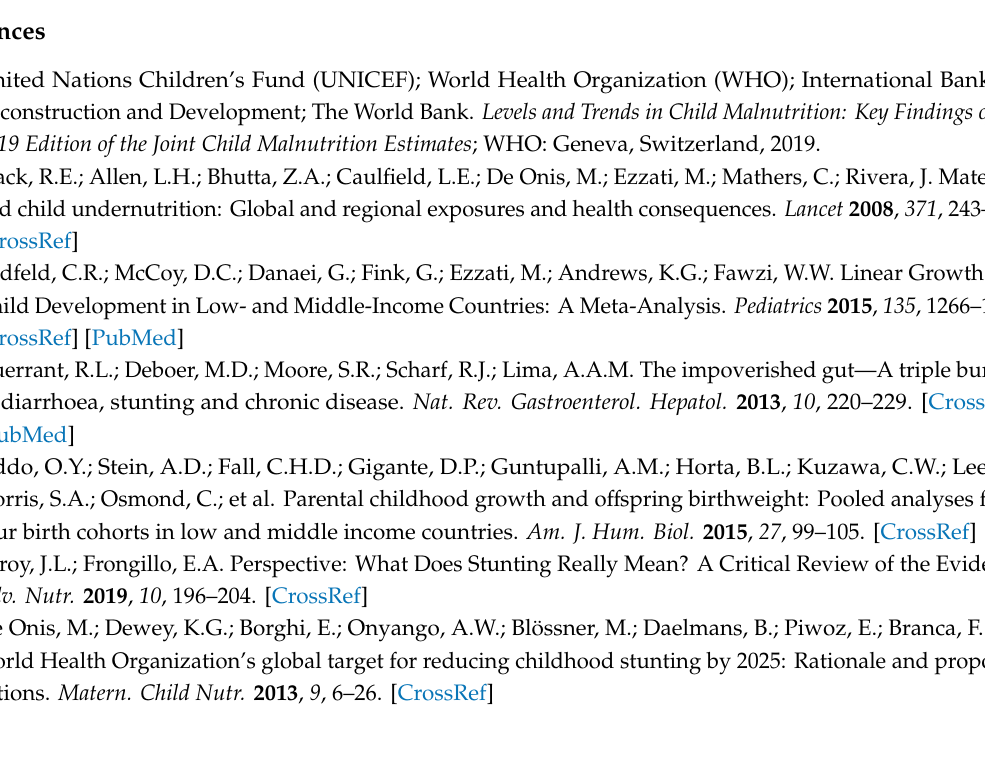
Figure S1: Trends in indicators by